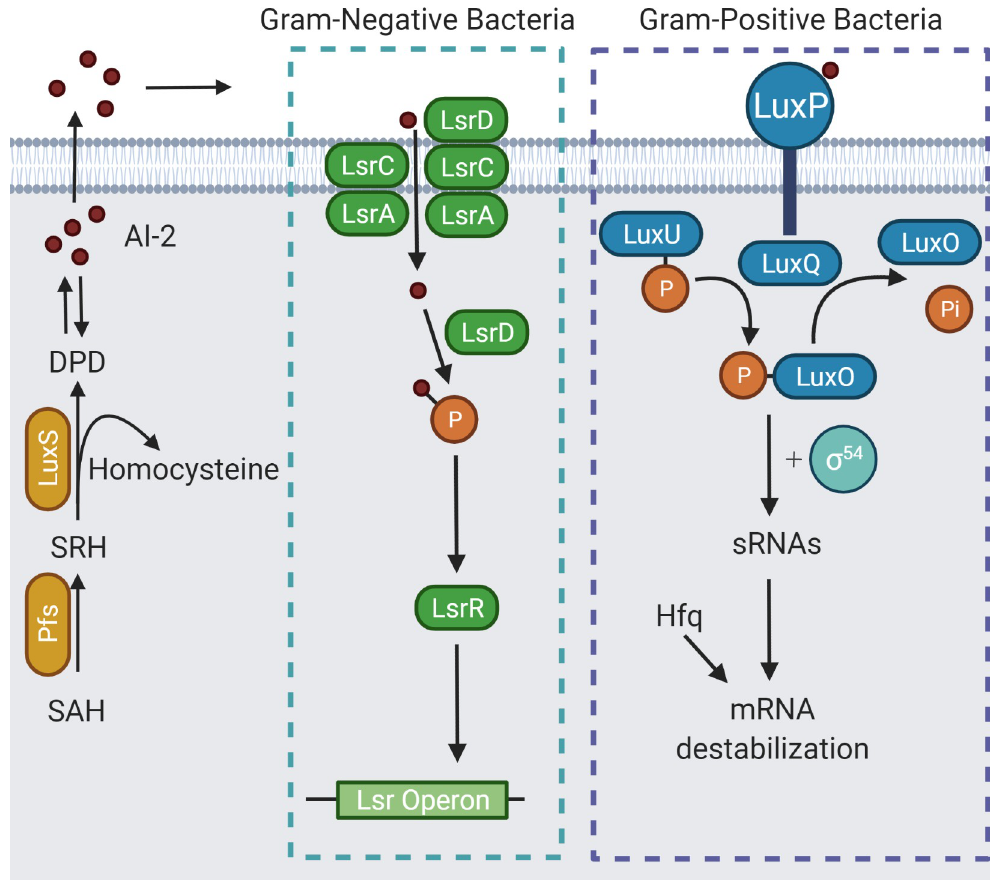
Fig 3. Overview of the LuxS QS system in both gram-negative and gram-positive bacteria. Both systems use the same signalling molecules, collectively named AI-2. Created with BioRender.com adapted from [96]. AI-2, autoinducer-2; QS, quorum